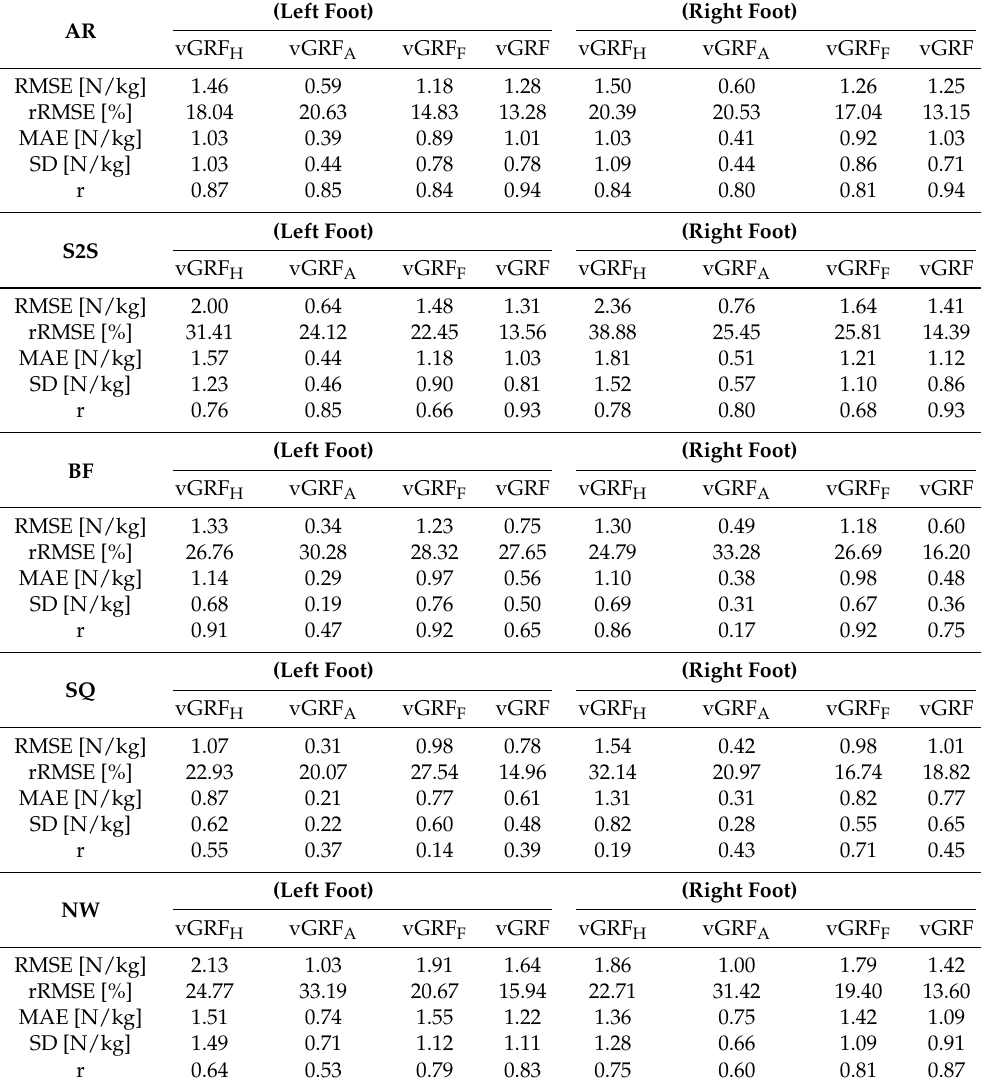
Table 1. Error metrics for the subregions, i.e., heel (vGRF H ), foot arch (vGRF A ), front foot (vGRF F ) and the total foot (vGRF), per movement for each foot. Walking with normal speed (NW), squatting (SQ), swaying all around (AR), from side to side (S2S) and back and forth (BF). The chosen metrics, i.e., root-mean-square error (RMSE), relative root-mean-square error (rRMSE), mean-absolute error (MAE), standard deviation (SD) and the correlation coefficient ( r ), are determined including all measured cycles per